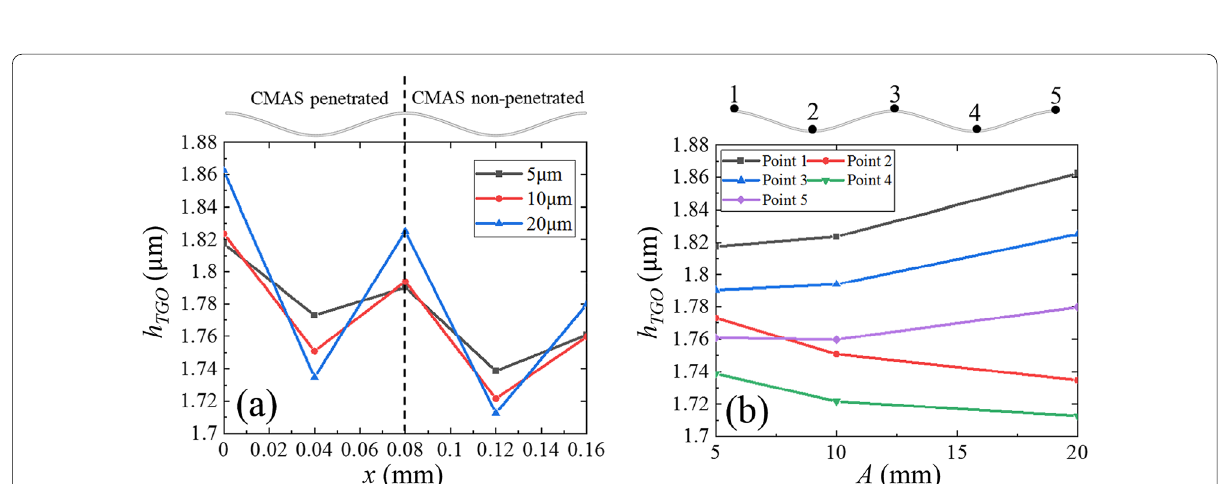
Figure 13 ( a ) Temperature contour of TGO in Zone II under different interface amplitudes ( A distribution of Zone II under different interface amplitudes, ( c ) temperature at peaks and valleys of interface under different interface amplitudes